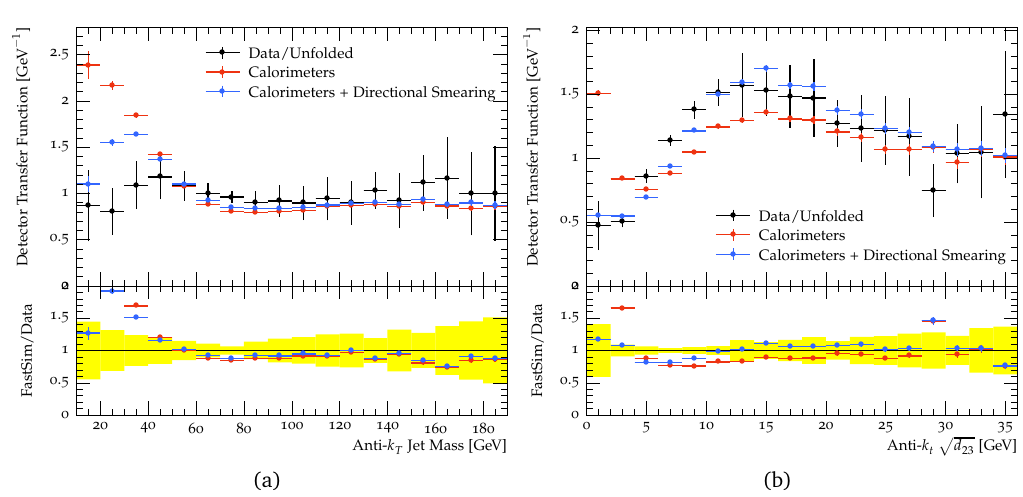
Figure 5: The detector transfer function extracted from data by dividing the detector- level distributions by the unfolded distributions, and two fast detector simulations with and without directional smearing for the R = 1.0 anti- k (cid:112) d scale as measured in a 7 TeV inclusive dijet sample with p 23 in Ref. [ 36 ]